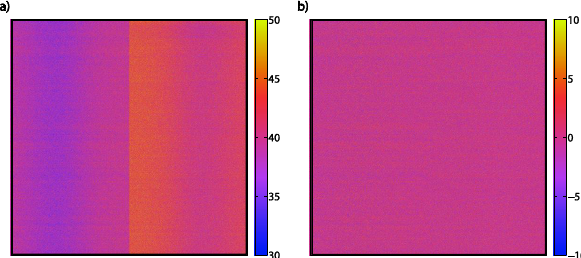
Figure 5. (a) An example dark frame for a 100ms exposure and (b) the corrected dark frame. Typical pixel values in (a) range from Fig. 5. (a) An example dark frame for a 100ms exposure and (b) the corrected dark 3 32 to 47 with a mean around 40 counts (of 2 12 ) . frame. Typical pixel values in (a) range from 32 to 47 with a mean around 40 counts 4 (of 2 12 ). 5 6